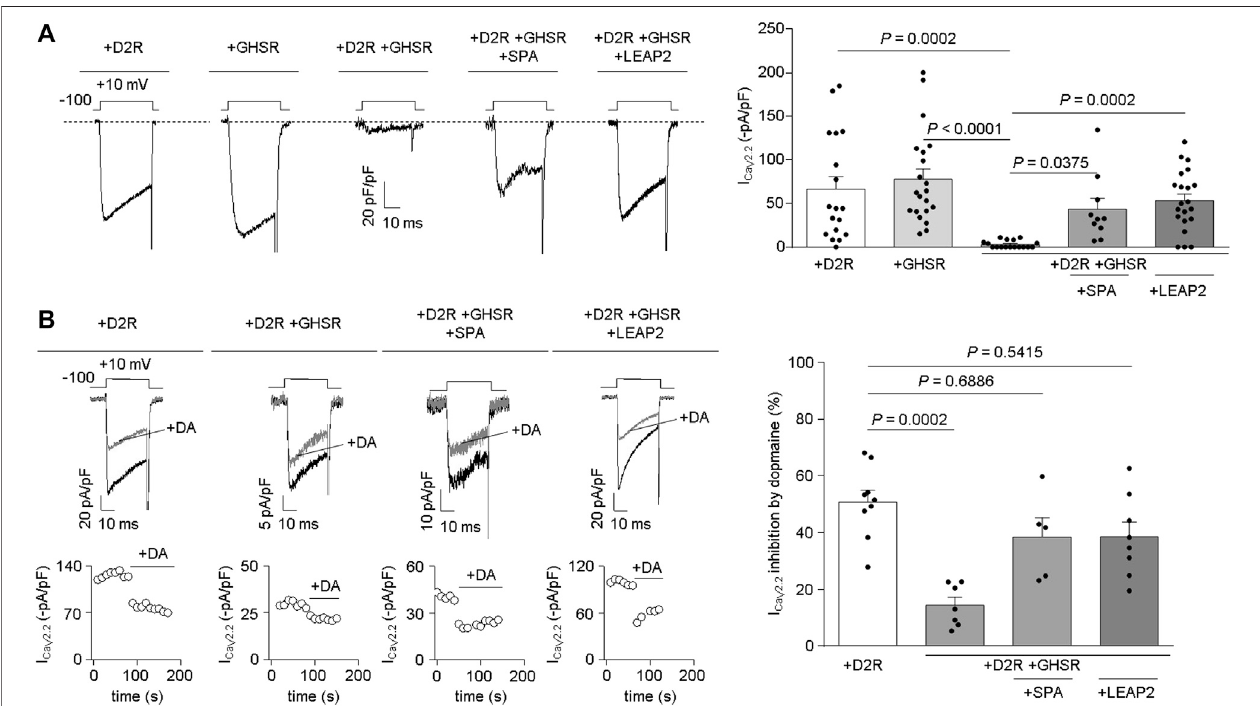
FIGURE 2 | LEAP2 impairs the basal reduction of Ca V 2.2 currents by GHSR and D2R coexpression and LEAP2 ameliorates the ability of GHSR to impair dopamine-induced inhibition of Ca V 2.2 currents. (A) Representative traces (left) of Ca V 2.2 current (I CaV2.2 ) from HEK293T cells cotransfected with Ca V 2.2, Ca V β 3 , Ca V α 2 δ 1 and either D2R (+D2R, n (cid:2) 18), GHSR (+GHSR, n (cid:2) 21) or GHSR and D2R (+D2R +GHSR, n (cid:2) 17) pre-incubated or not with 1 µM SPA (+D2R +GHSR +SPA, n (cid:2) 10) or 0.1 µM LEAP2 (+D2R +GHSR +LEAP2, n (cid:2) 21) in a 0.1 GPCR:Ca V 2.2 molar ratio. Bars (right) represent averaged I CaV2.2 levels for each condition. Statistical signi fi cance was evaluated by Kruskal-Wallis and Dunn ’ s post-test. (B) Representative traces and time courses (left) of Ca V 2.2 current (I CaV2.2 ) from HEK293Tcells cotransfected withCa V 2.2, Ca V β 3 , Ca V α 2 δ 1 and D2R (+D2R, n (cid:2) 9) or GHSR and D2R pre-incubated or not (+D2R +GHSR, n (cid:2) 7) with 1 µM SPA (+D2R +GHSR +SPA, n (cid:2) 5) or 0.1 µM LEAP2 (+D2R +GHSR +LEAP2, n (cid:2) 8) in control condition and after dopamine application (10 µM, +DA); 0.1 GPCR:Ca V 2.2 molar ratio. Bars (right) represent averaged I CaV2.2 inhibition by 10 µM dopamine application for each condition. Statistical signi fi cance was evaluated by Kruskal-Wallisand Dunn ’ s post-test (versus +D2R). The test-pulse protocol consisted in square pulses applied from − 100 to +10 mV for 30 ms every 10 s.